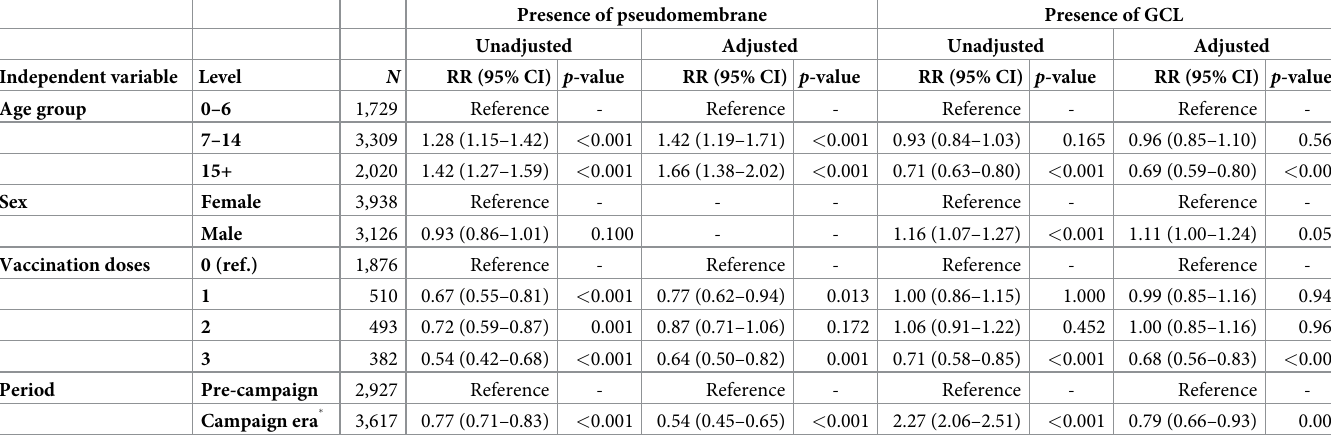
Table 6. Multivariable Poisson regression for risk factors for diphtheria patients presenting with pseudomembrane and lymphadenopathy, Cox’s Bazar, Bangla- desh, November 10, 2017 to November 10, 2019. Presence of